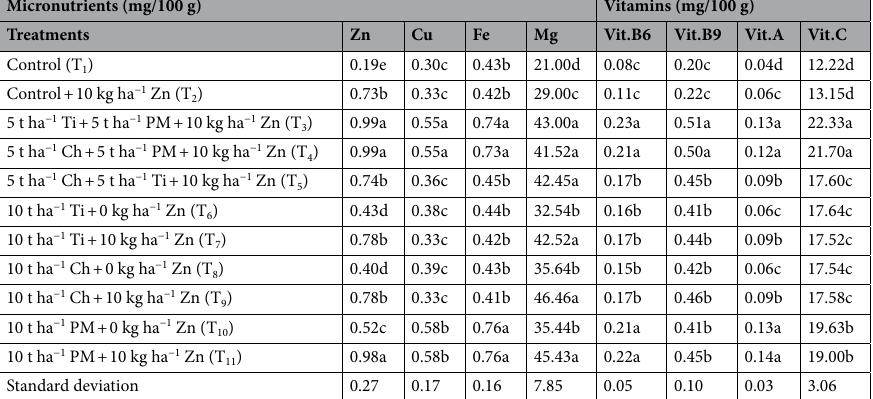
Micronutrients (mg/100